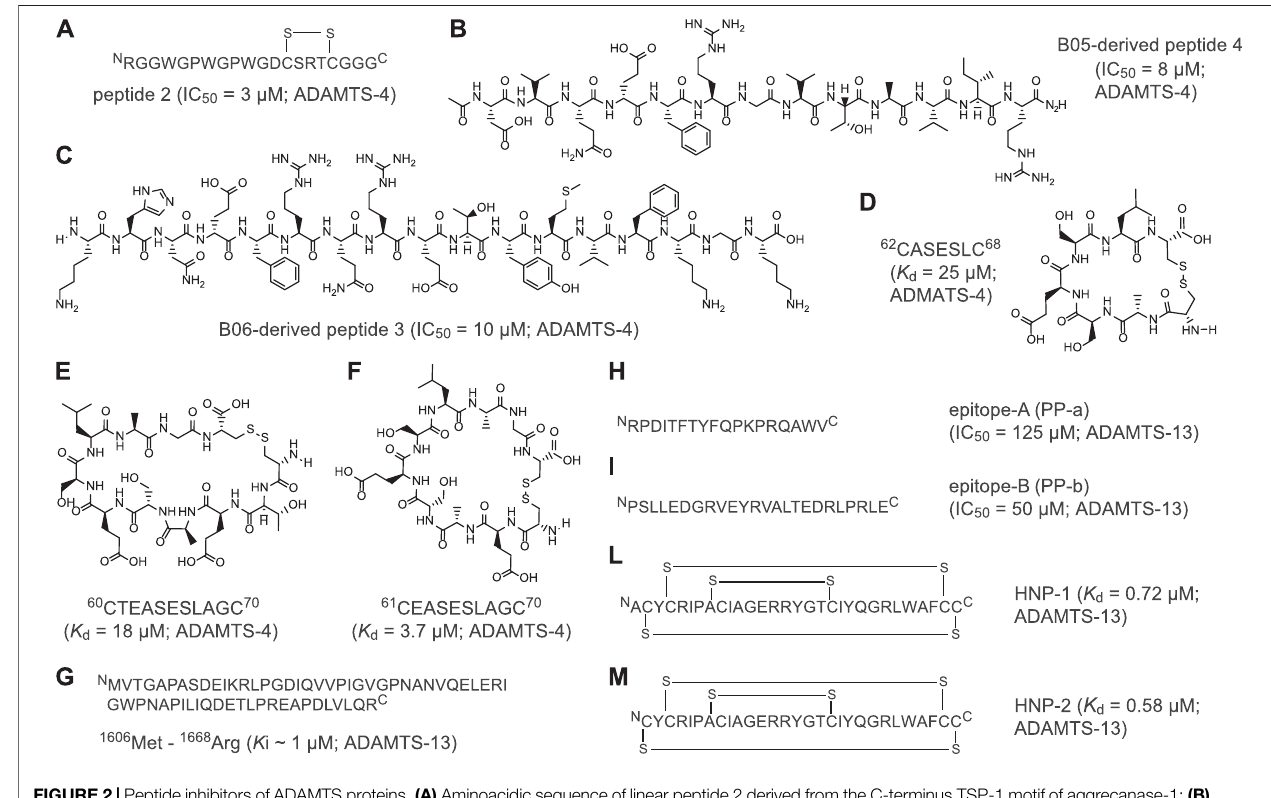
Frontiers in Molecular Biosciences |